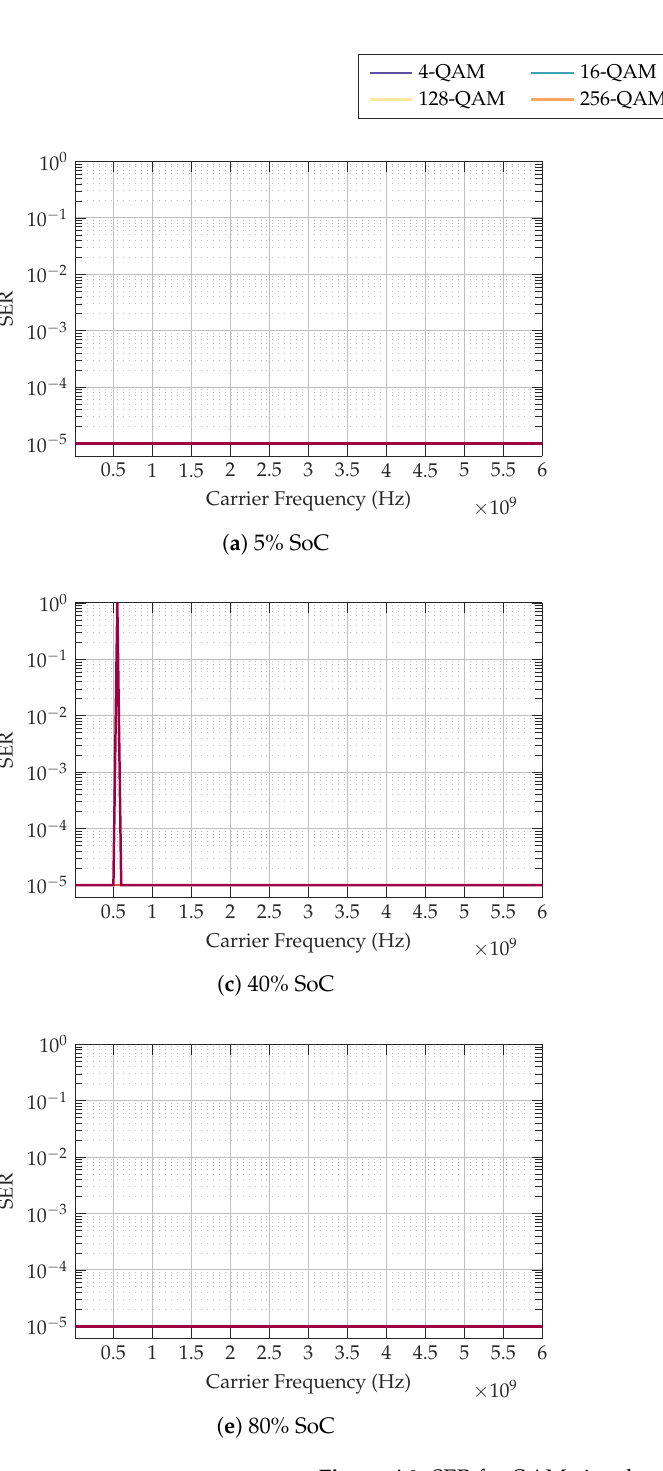
9 dBm through a Li-ion −